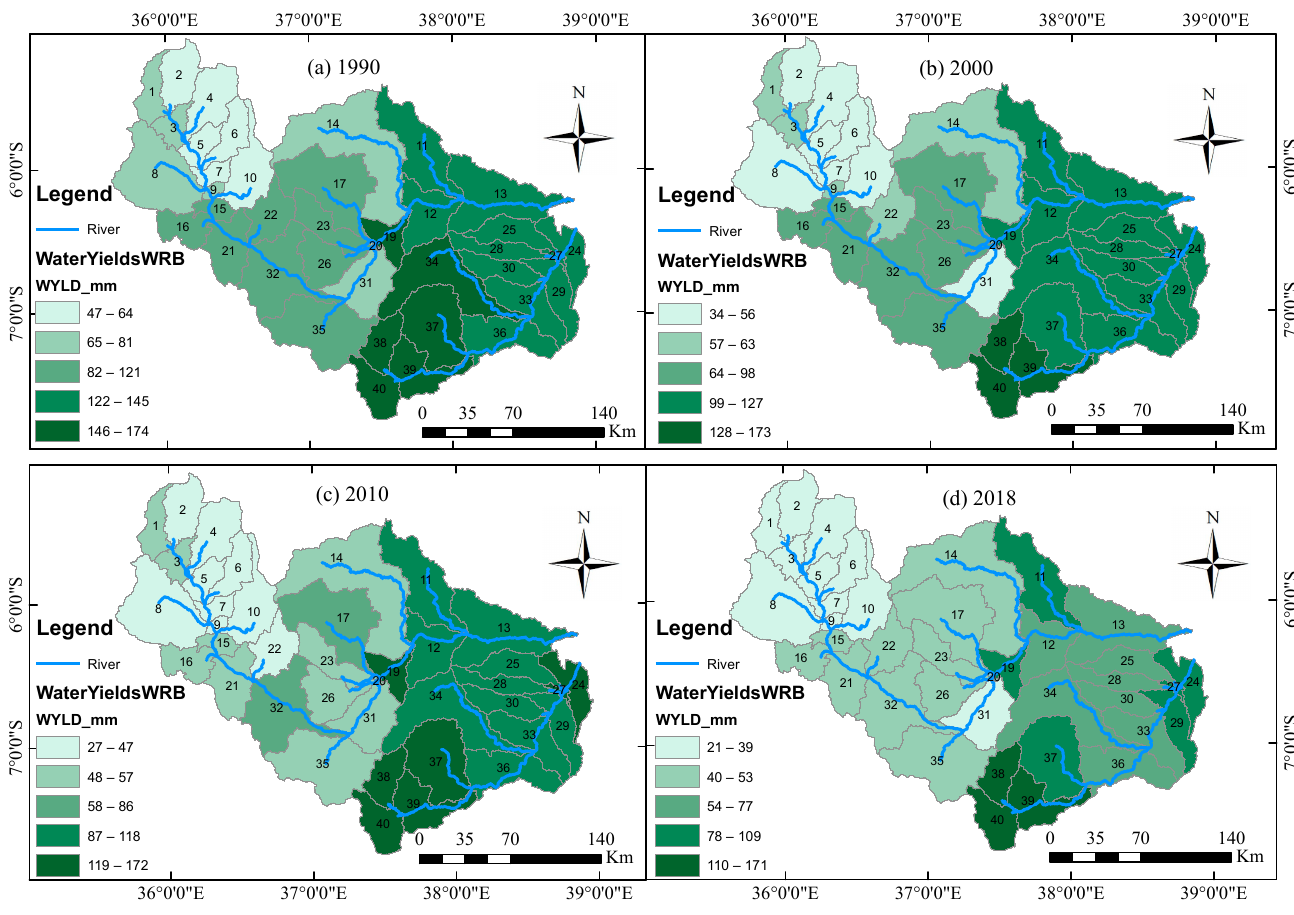
Figure 9. The spatial WYLD distribution in the WRB for ( a ) 1900, ( b ) 2000, ( c ) 2010, and ( d ) 2018. Note: The numbers 1–40 are sub-catchments from the delineation process. Table 9. The long-term simulation results of WYLD and its major components in the WRB. Wami Hydrological Component